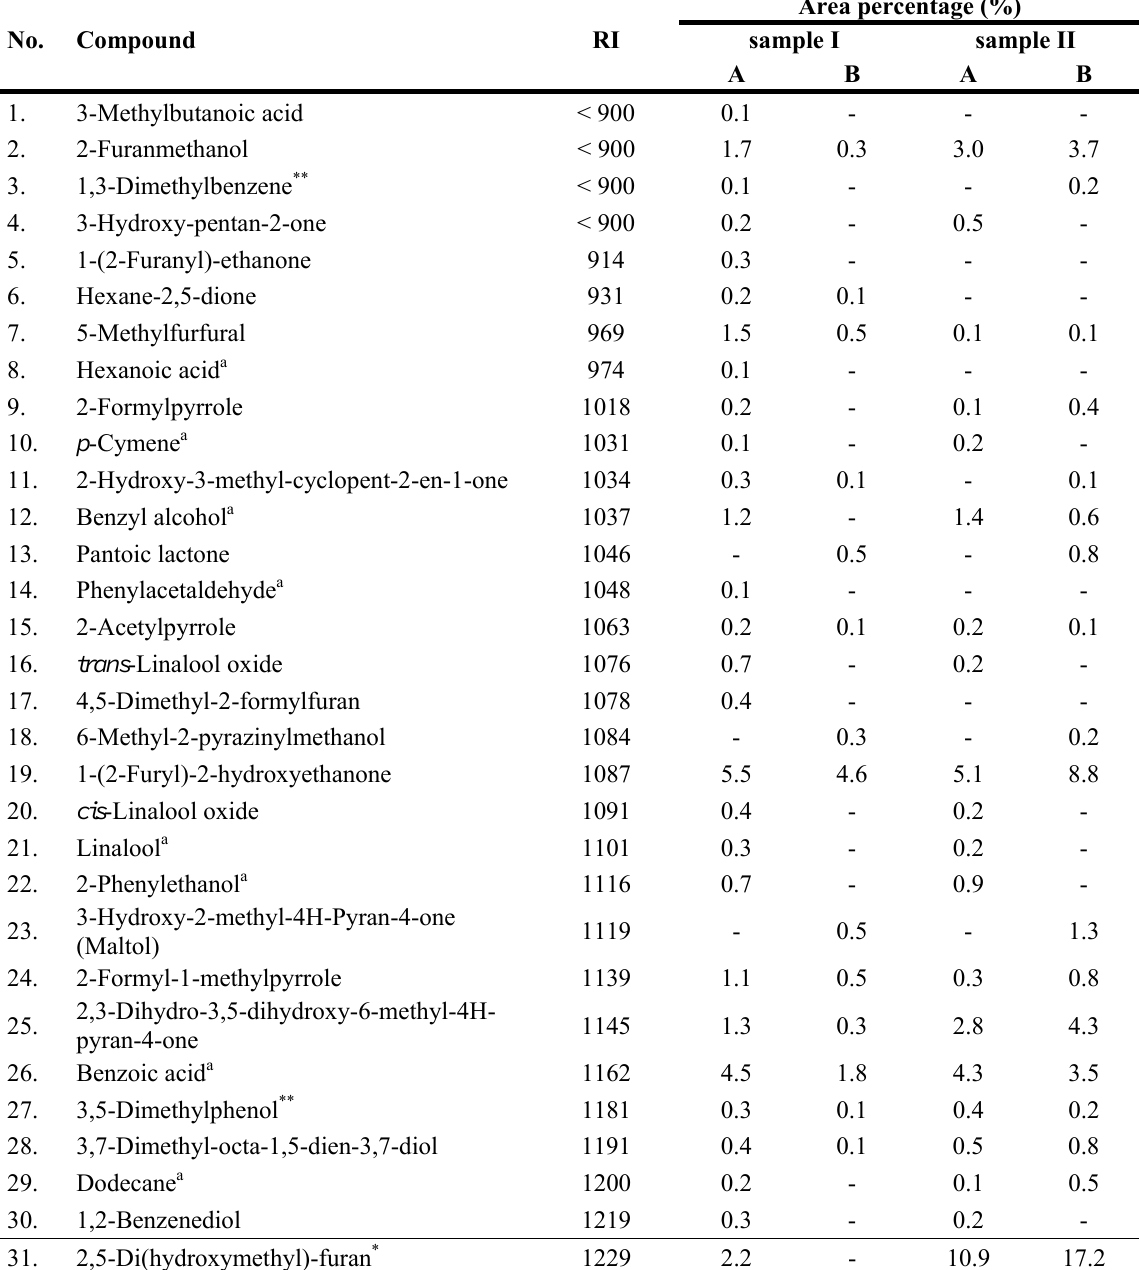
Table 2. Oak honey volatile organic composition isolated by